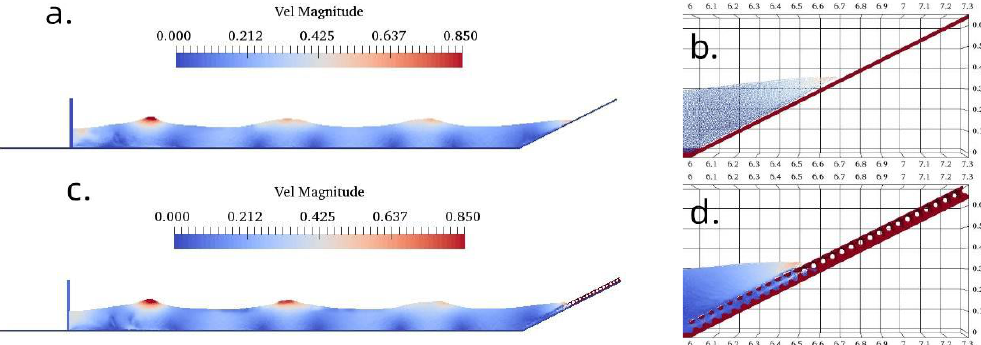
Figure 8. The same as Figure 7, but for wave climbing along the breakwater at t = 5.45 s.